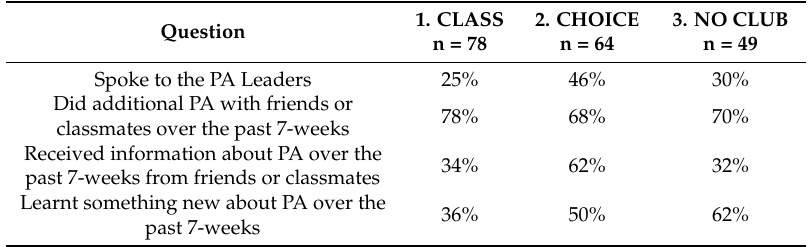
Note. % = Percentage of respondents who answered ‘yes’ to